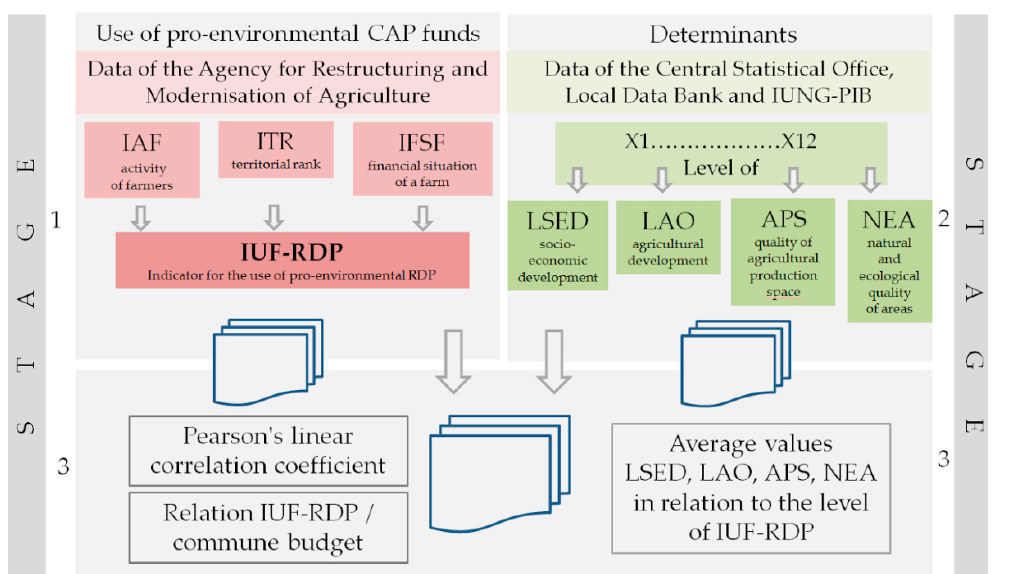
Figure 1. Research procedure.